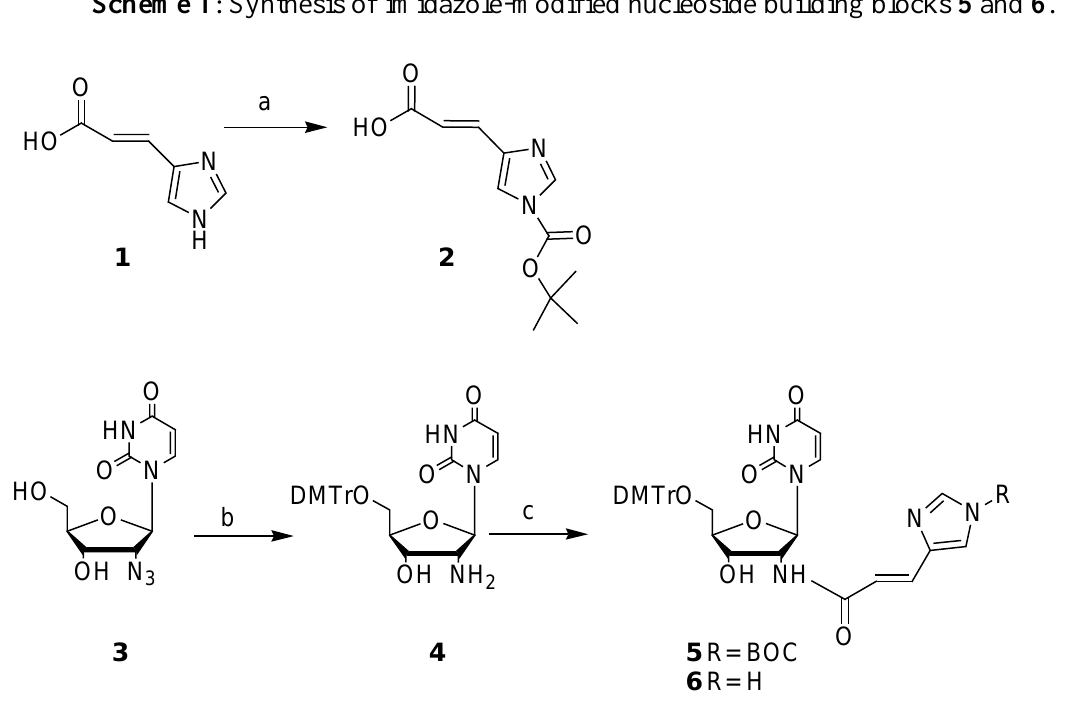
Scheme 1 : Synthesis of imidazole-modified nucleoside building blocks 5 and 6